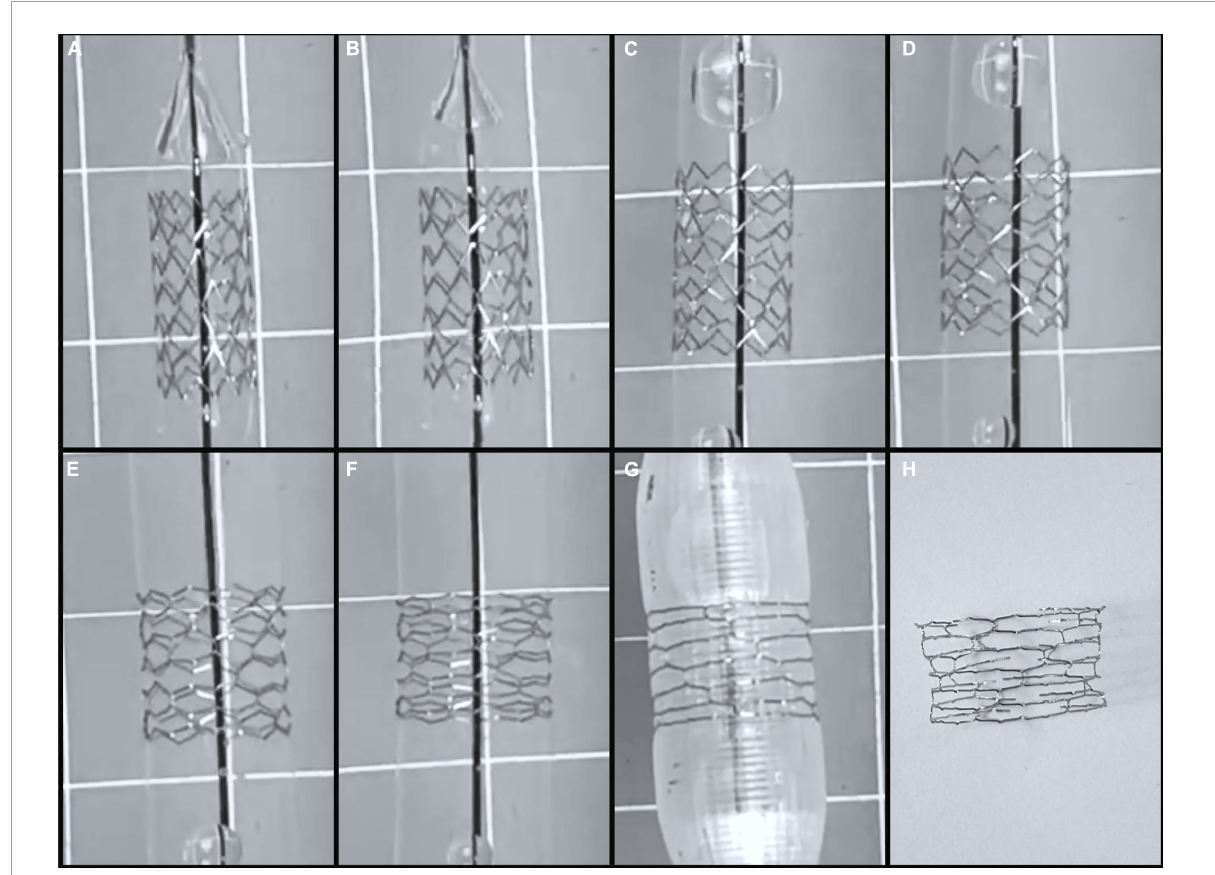
FIGURE4 Serial dilation of 8 mm by 15 mm Lifetech Iron-Based Bioresorbable Scaffold Angel stent. (A) 8 mm stent on premounted 7 mm balloon at 6 atm, (B) premounted 7 mm balloon at 12 atm, (C) 8 mm balloon at 6 atm, (D) 8 mm balloon at 12 atm, (E) 10 mm balloon at 6 atm, (F) 10 mm balloon at 12 atm, (G) 12 mm balloon at 6 atm which was point of first strut fracture. (H) Stent post complete strut